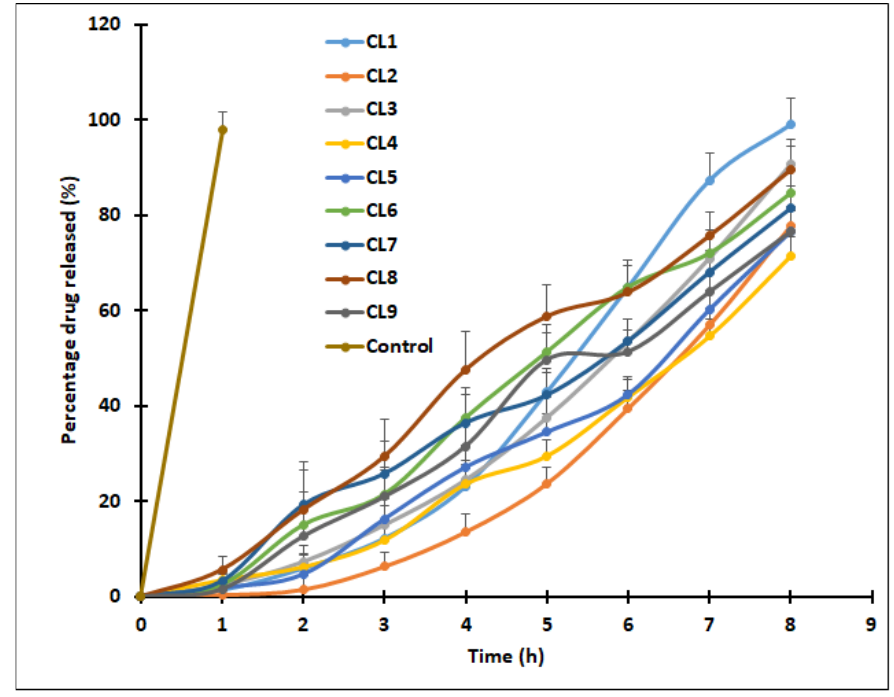
Figure 8. Comparison of percentage of clarithromycin release from solid lipid nanoparticles (CL1–CL9) and drug solution (control). Data represented are mean ± SD ( n = 6).